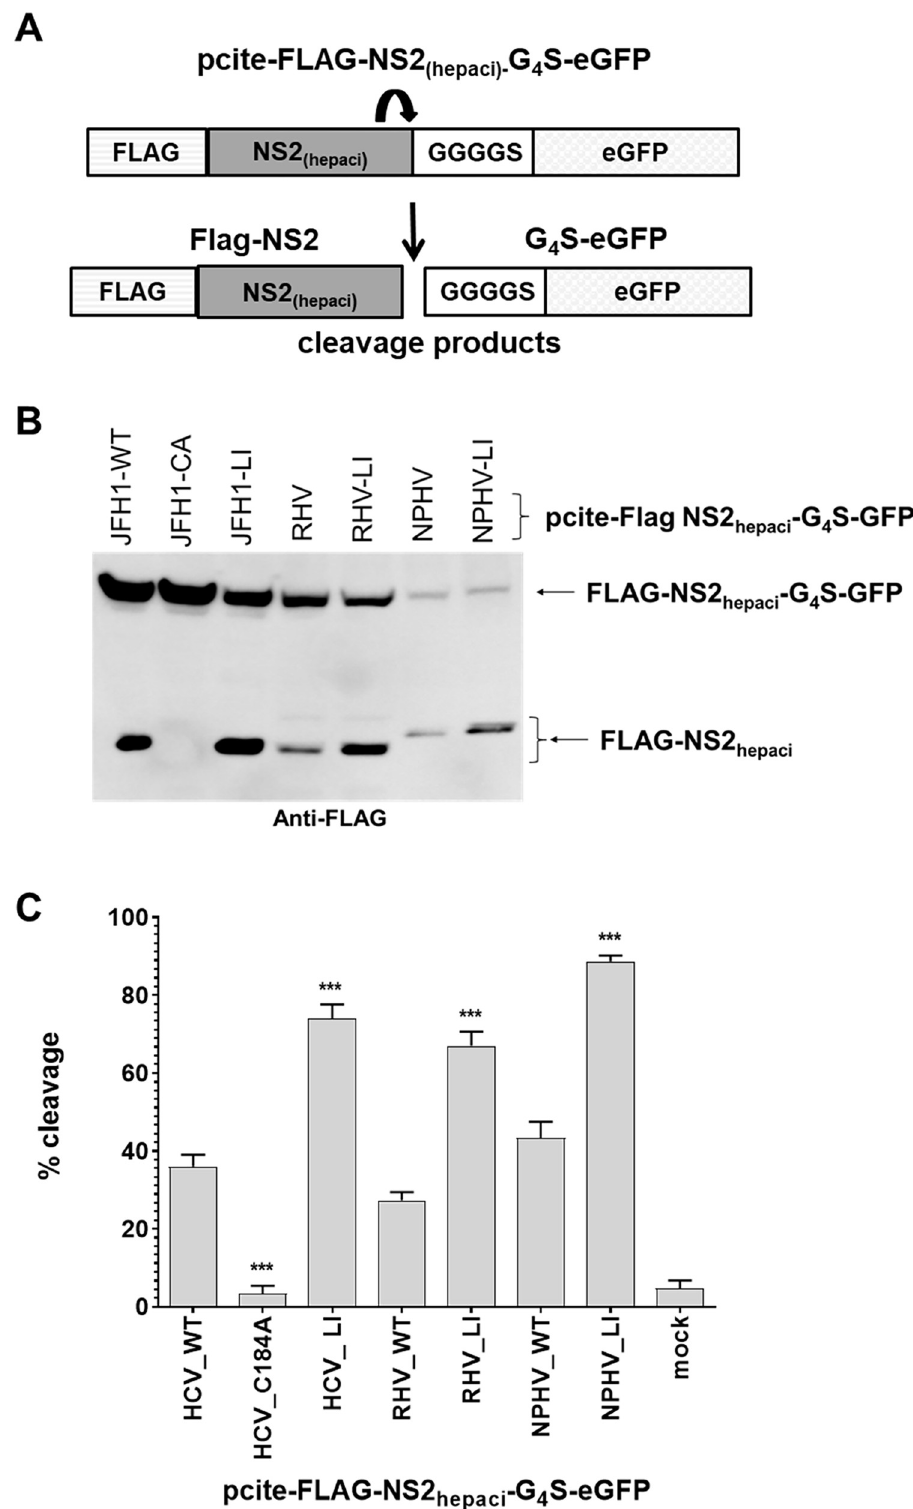
Fig 7. Leucine-to-isoleucine exchanges in other hepaciviral NS2 proteins corresponding to mutation HCV NS2 L144I are activating the intrinsic NS2 pro activity. (A) Scheme of pcite-FLAG-NS2 hepaci -G 4 S-eGFP reporter construct to analyze the intrinsic NS2 protease activity of related mammalian hepaciviruses. (B) Indicated pcite plasmid